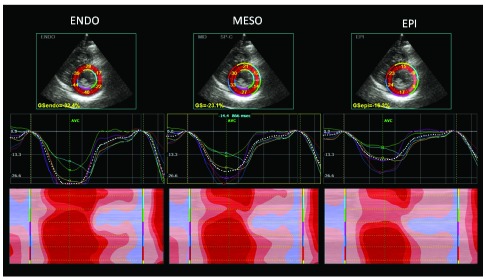
Short-axis left ventricular 2-D strain of endurance athlete, showing optimal regional myocardial deformation of all myocardial layers (arrows) (Epi: epicardium; meso: mesocardium; endo: endocardium).